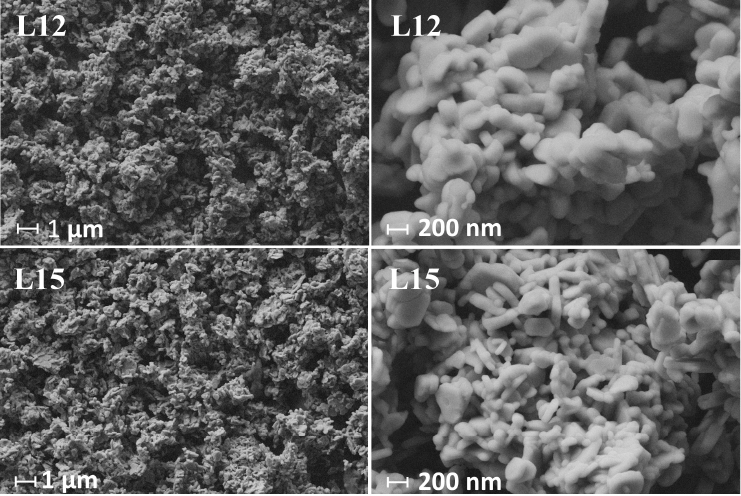
Figure 6. SEM images of samples L12 and L15 under different degrees of